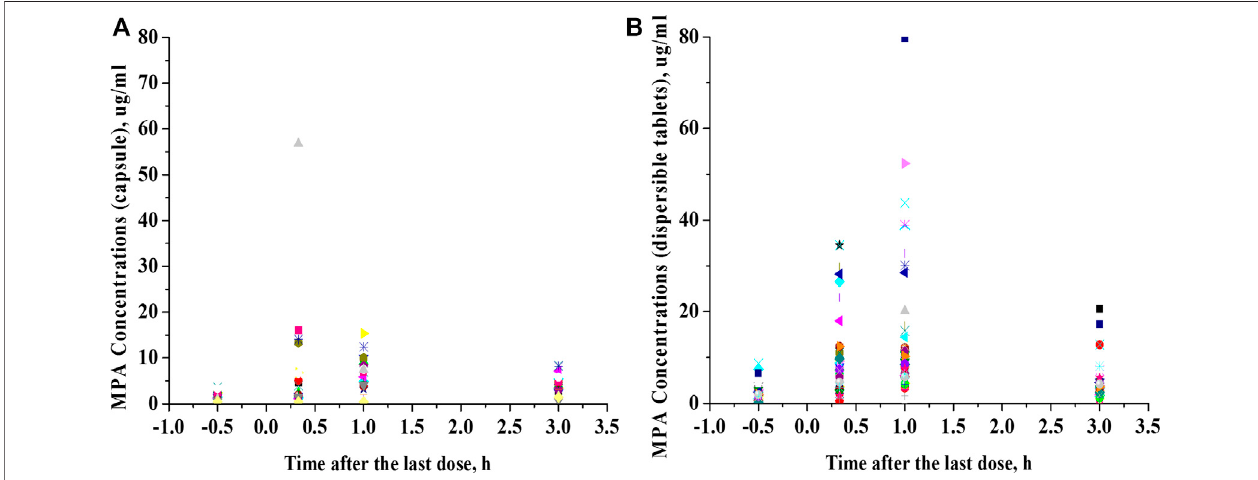
FIGURE 2 | Comparison of PK pro fi les of different dosage forms. (A) , Mycophenolate mofetil capsules. (B) , Mycophenolate mofetil dispersible tablets.